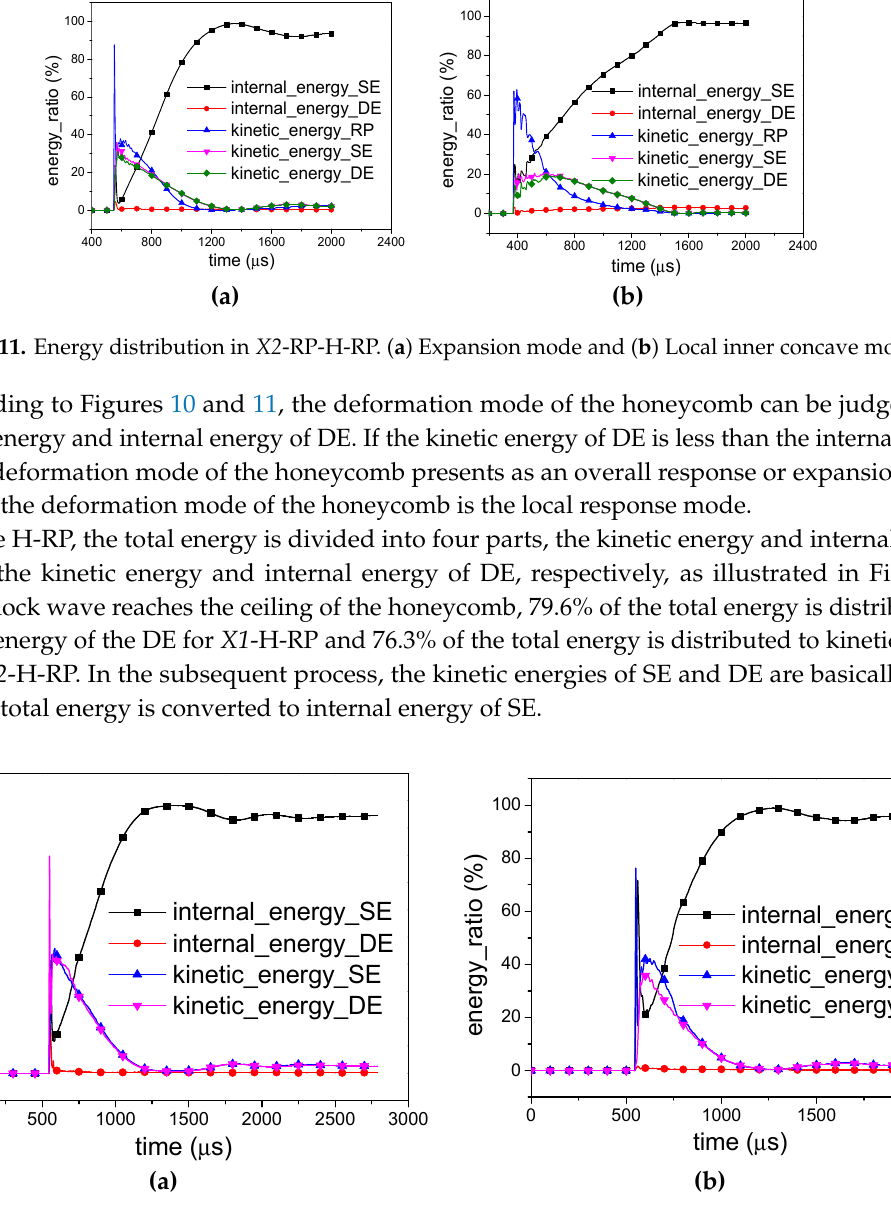
Figure 12. Energy distribution of H-RP. (a) X1 -H-RP-10g and (b) X2 -H-RP-10g.